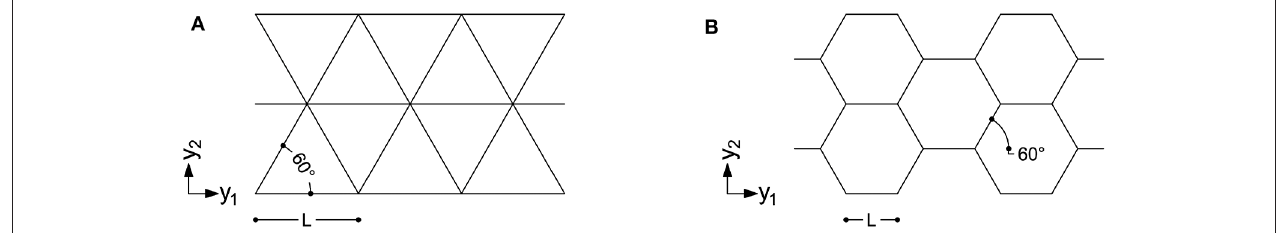
FIGURE 1 | Two lattices used in structural grids: (A) an isotropic triangular lattice of a diagrid; (B) an isotropic hexagonal lattice of a hexagrid (B) (drawn in the micro-scale reference system).